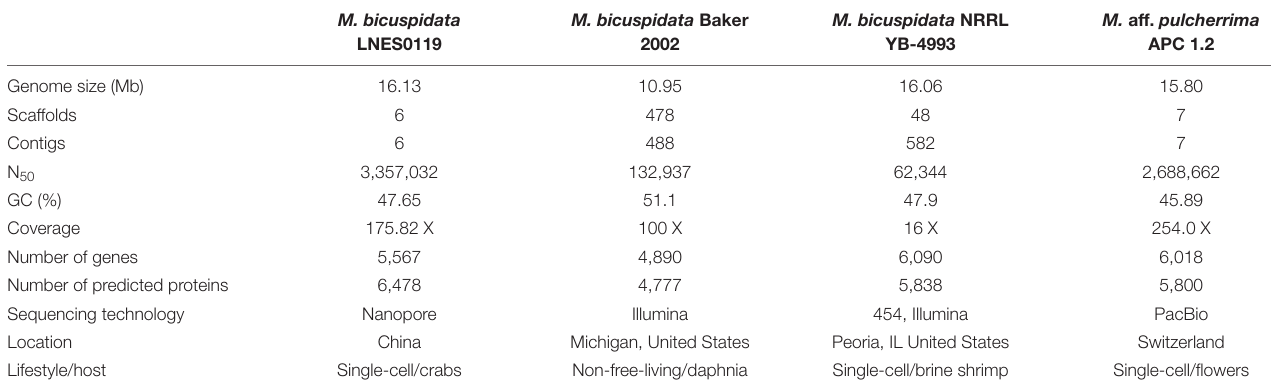
TABLE 1 | Genome characteristics of four Metschnikowia species strains.